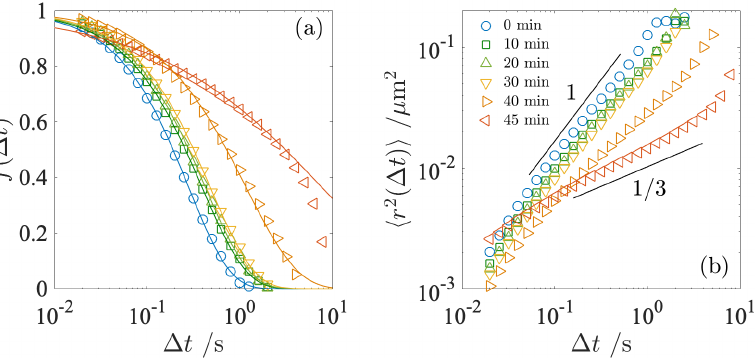
Figure 6. Intermediate scattering function f ( ∆ t ) measured at different t ( a ). Symbols correspond to the data obtained at different t , 0 min ( (cid:13) ), 10 min ( (cid:3) ), 20 min ( (cid:52) ), 30 min ( (cid:79) ), 40 min ( (cid:46) ), and 45 min ( (cid:47) ). Solid curves are the best fit to Equation (2). Mean square displacement (MSD) at each t , (cid:104) r 2 ( ∆ t ) (cid:105) , is shown in ( b ). In the panel ( b ), two lines with slope of 1 and 1/3 are shown as the guide for